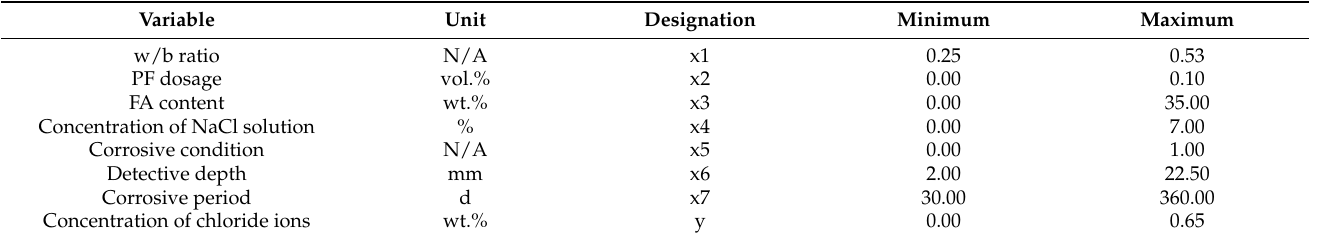
Table 9. Variables and designations in the adaptive neuro-fuzzy inference system